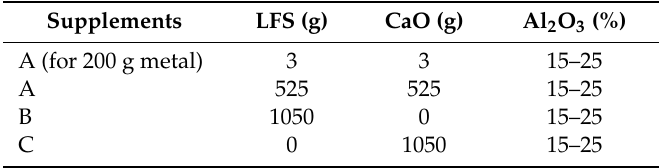
Table 2. Materials of supplement, reagent grade CaO, and Al 2 O 3 were used. The amount of Al 2 O 3 is 15% to 25% by weight of the slag, depending on the initial chemical composition of the